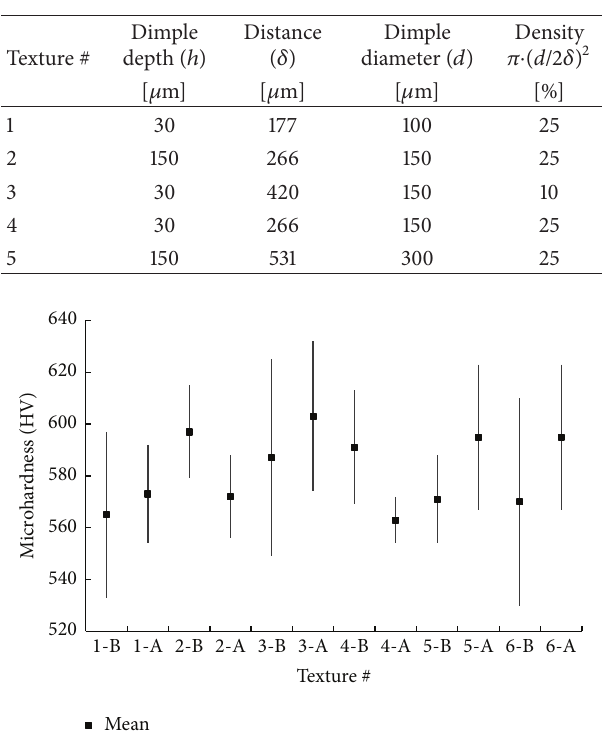
Table 2: Dimensions of the texture parameters shown in Figure 1.